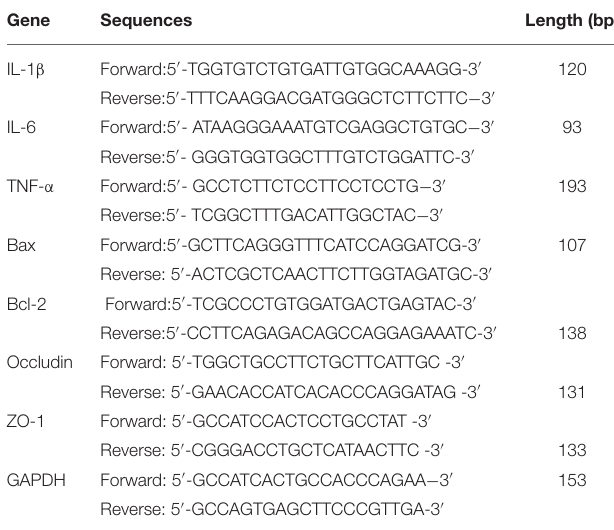
TABLE 2 | Primers for real-time PCR (Sus